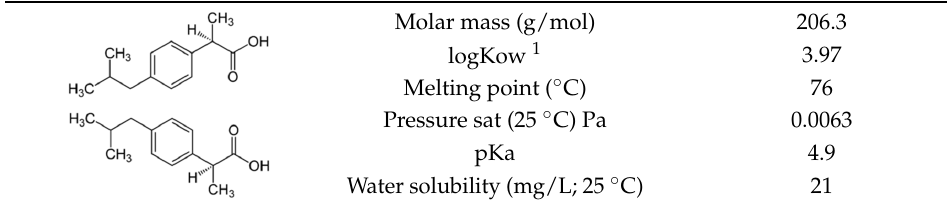
Table 1. Most important properties of IBU.